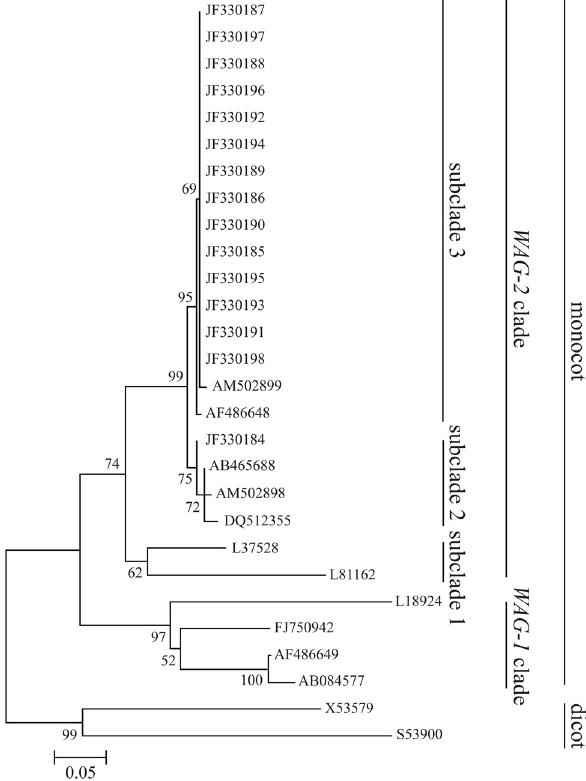
Figure 3 - Neighbor-joining phylogenetic tree of AG group MADS-box genes. Predicted amino acid sequences of the partial coding region were obtained from the NCBI: X53579 ( AG ) from Arabidopsis , (S53900) PLE from Antirrhinum , (L18924) ZAG1 and L81162 ( ZMM2 ) from maize, L37528 ( OsMADS3 ) and FJ750942 ( OsMADS58 ) from rice, AF465688 ( HvAG1 ) and AF486649 ( HvAG 2) from barley, AB084577 ( WAG - 1 ), AB465688 ( WAG - 2 ), AM502898 ( WM29A ), AM502898 ( WM29B ) and DQ ( TaAGL39 ) from wheat. The GenBank accession numbers (JF330184 toJF330198)forthecloned WAG-2 sequencesareshowninTable1.Boot- strap values are shown as percentages for 1000